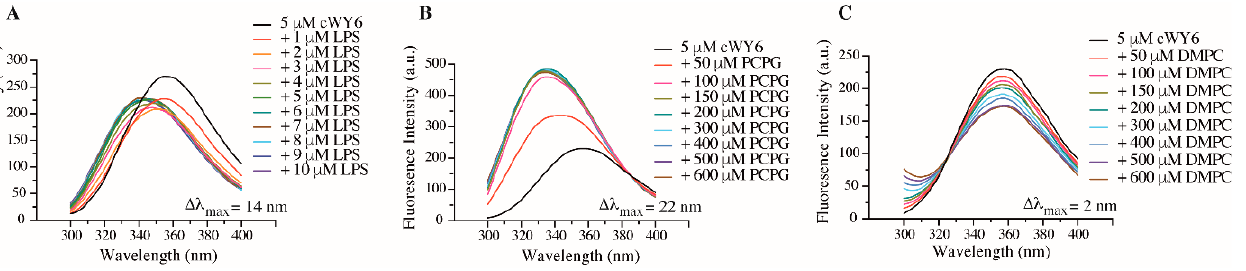
Figure 4. Fluorescence emission spectra of Trp residue of cWY6 peptide at increasing concentrations of ( A ) LPS micelle, ( B ) POPC/POPG 3:1 liposomes and ( C ) DMPC liposomes.